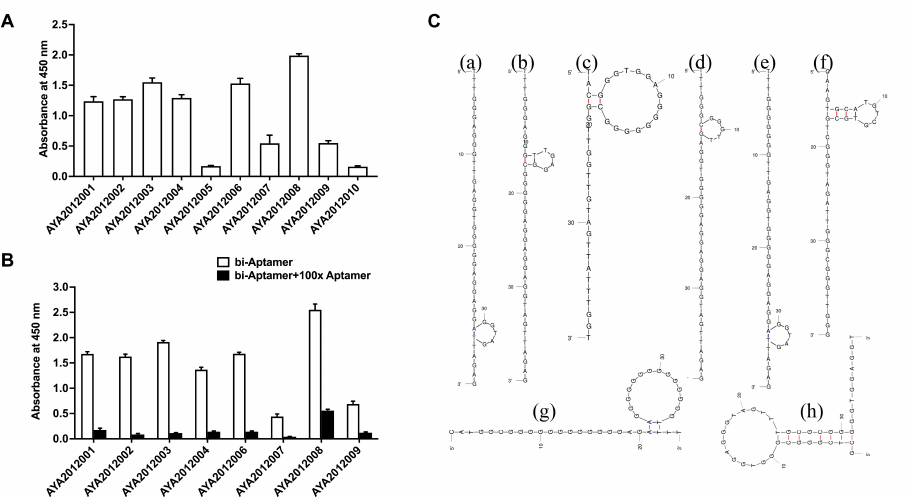
Figure 2. Aptamers binding to recombinant SARS-CoV-2 trimer S protein. ( A ) ELISA-based binding assay of the most enriched aptamer sequences after 12 rounds of selection. SARS-CoV-2 trimer S protein was immobilized on MaxiSorp plate and 10 nM of biotinylated aptamers were incubated with the immobilized protein. Bound aptamers were detected using streptavidin–HRP. ( B ) ELISA- based competition assay for the binding of the aptamers to SARS-CoV-2 trimer S protein. SARS- CoV-2 trimer S protein was immobilized on a MaxiSorp plate and 10 nM biotinylated aptamers were added in the absence or presence of 100-fold excess of non-biotinylated respective aptamers. Bound aptamers were detected using streptavidin–HRP. Each value was the average of duplicate measurements. Error bars represent mean ± SD ( σ ). ( C ) The predicted secondary structure of selected aptamers that bind to SARS-CoV-2 S protein. The predicted secondary structures of ( a ) AYA2012001, ( b ) AYA2012002, ( c ) AYA2012003, ( d ) AYA2012004, ( e ) AYA2012006, ( f ) AYA2012007, ( g )